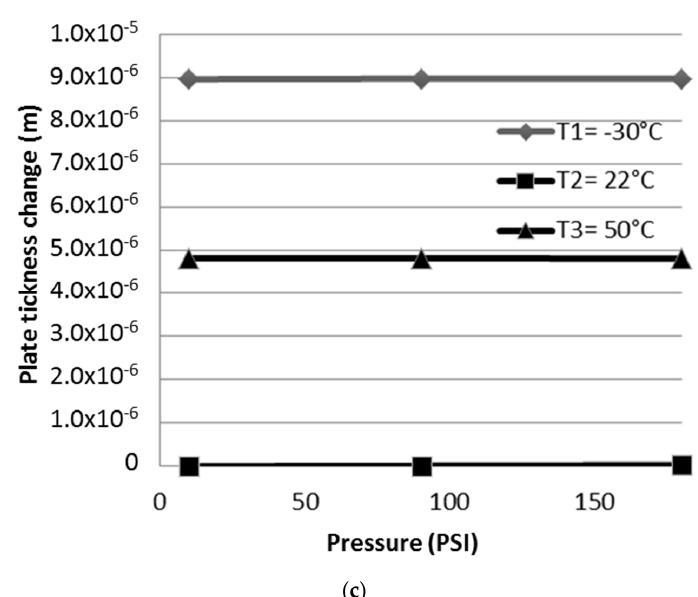
Figure 10. Changes in tube thickness for each case, in ( a ) tube without cavity, ( b ) tube with cavity and with pressure in p c and p t , and ( c ) tube with cavity, pressure in p c and p t is eliminated. The cavity inside the plate subjected to different temperatures and pressures, suffers dimension changes which are shown in Figure 11a,b. Δ x and Δ y obtained with the presence of p c and p t . Figure 11c,d, shows the resulting Δ x and Δ y obtained when p t is eliminated. With respect to the stress distribution, the presence of the pressure inside the tube creates a difference around the cavity as shown in Figure 11e. The maximum stress levels are located on the horizontal sides and the magnitude depends on the applied pressure. Figure 11f, shows the stress distribution around the cavity without the pressure inside the tube.